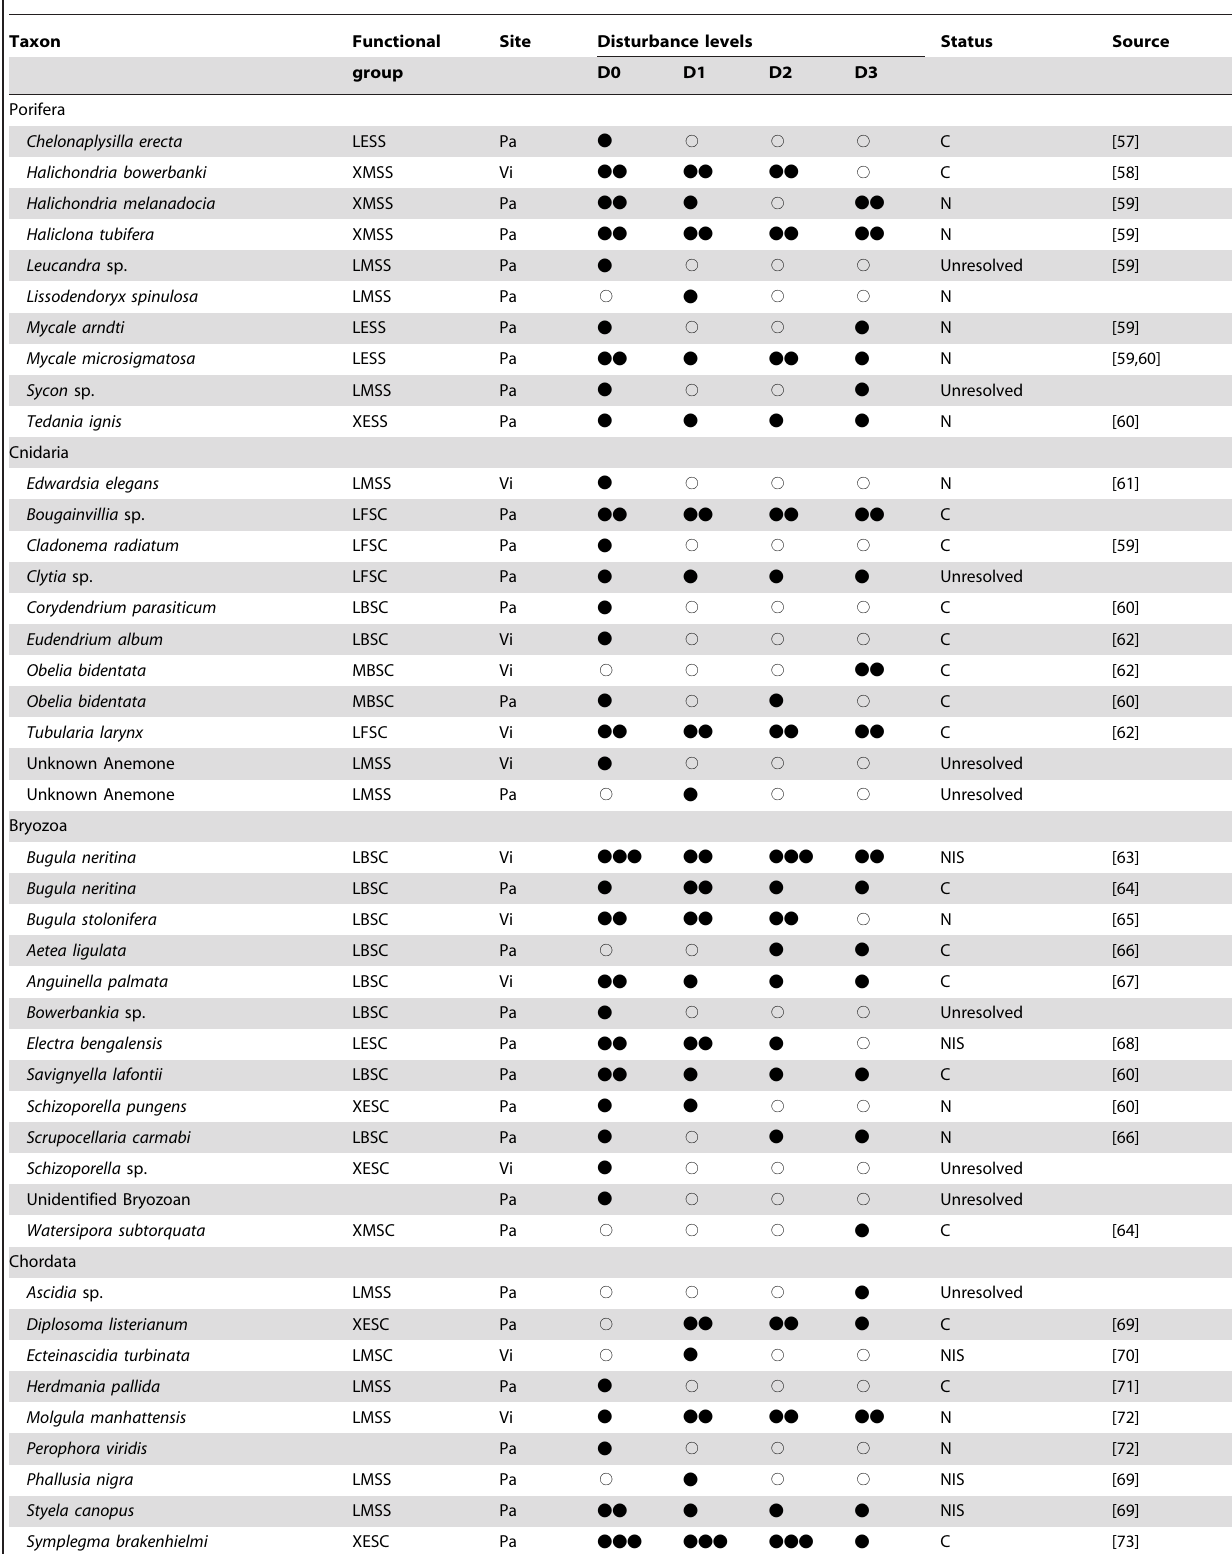
Table 1. List of macroinvertebrates and their respective functional groups (see [38] for details) set by phylum found across the four disturbance treatments (D0–D3) in Panama (Pa) and Virginia (Vi) after 9 weeks of colonization.